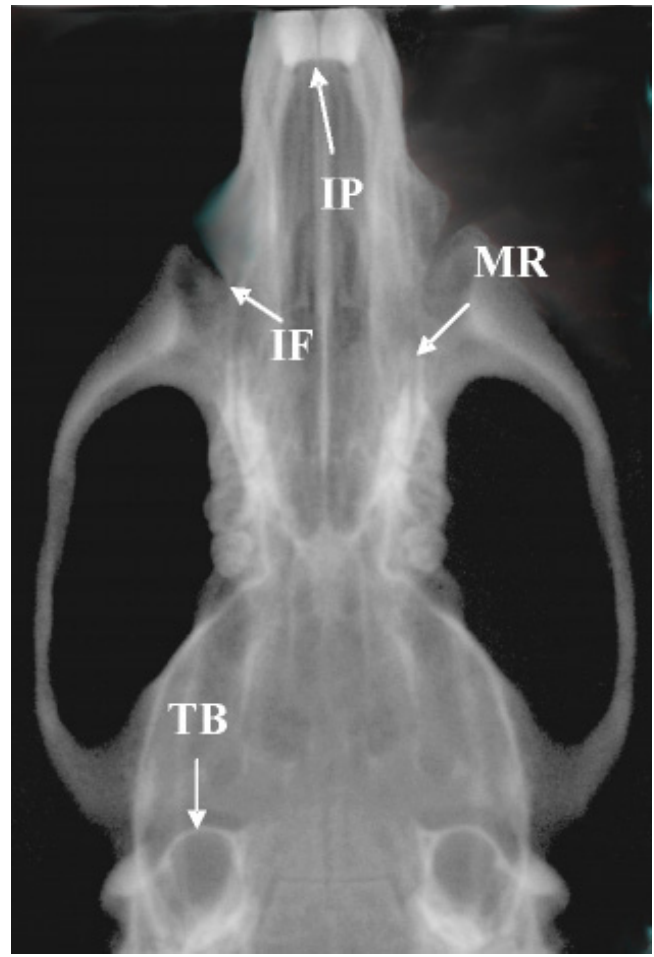
FIGURE 1 - Axial radiograph of the skull.